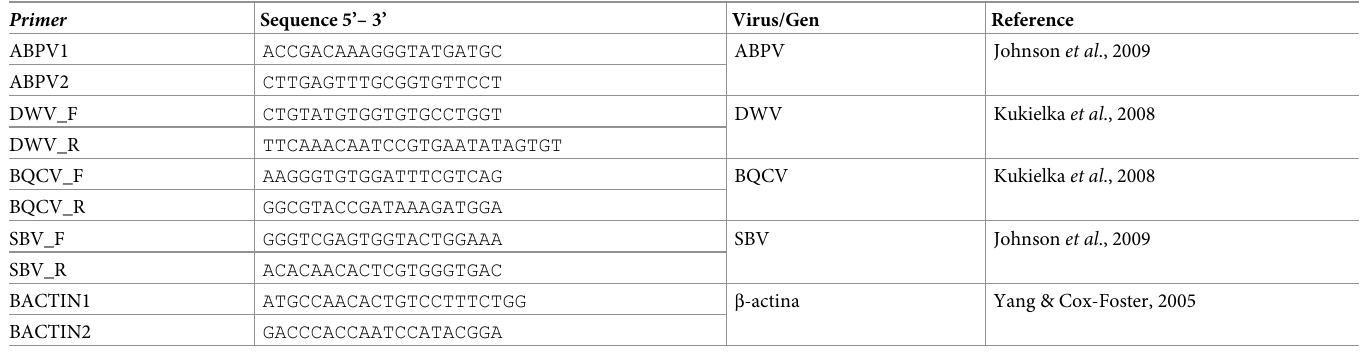
Table 1. Primers utilized for the quantification of viruses in the samples through